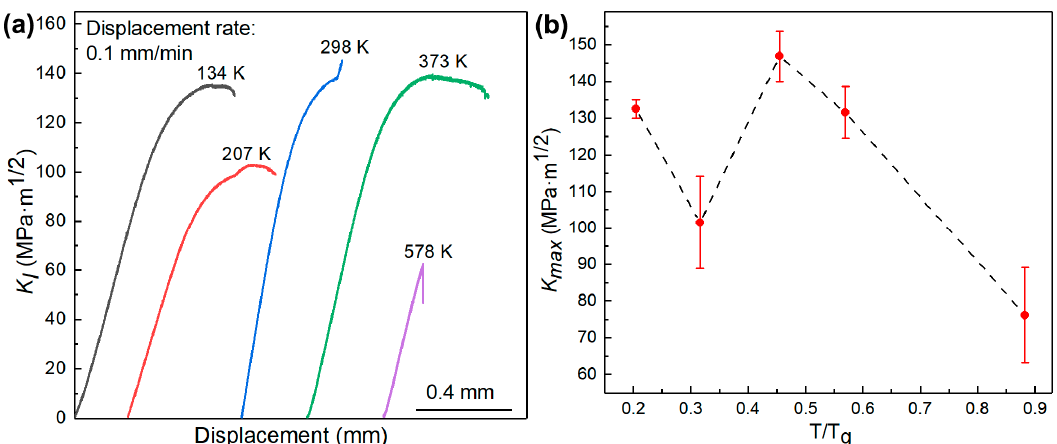
Figure 2. Temperature-dependent fracture toughness of the BMG samples. ( a ) K I (mode I stress intensity factor) vs. crosshead displacement curve at various temperatures. ( b ) Fracture toughness of the samples at various temperatures.